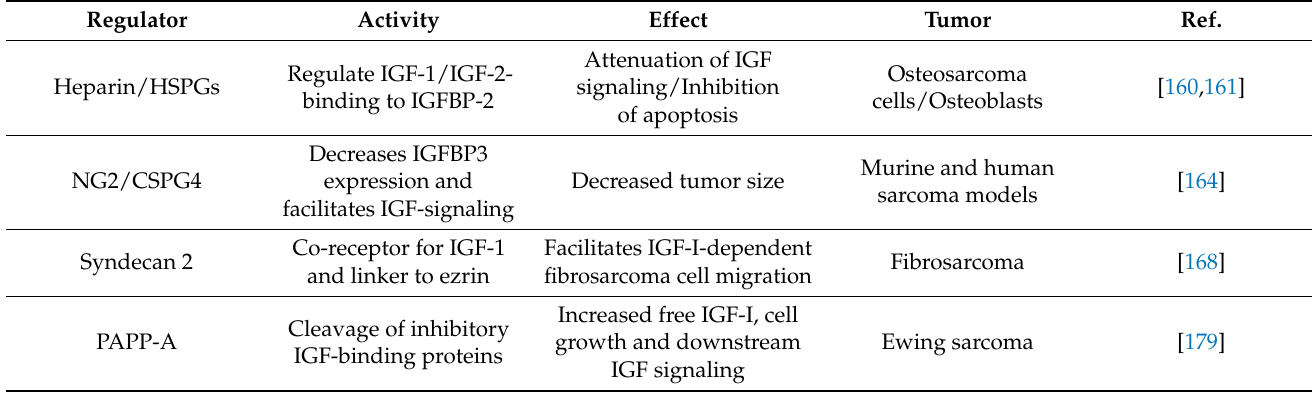
Table 2. Matrix mediators affect IGF/IGF-IR-dependent sarcoma cell functions.